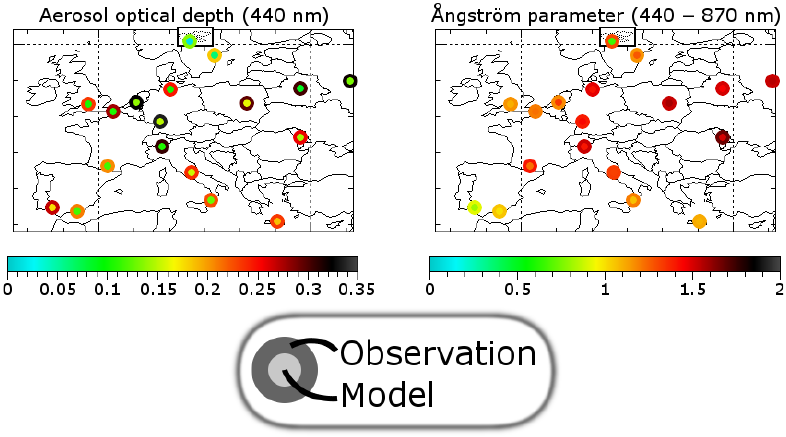
Fig. 8. Graphical overview of the comparison between modelled and observed AOD (440nm) and ˚Angstr¨om parameter (440–870nm) at AERONET stations. The island in the upper box is Svalbard (Norway).